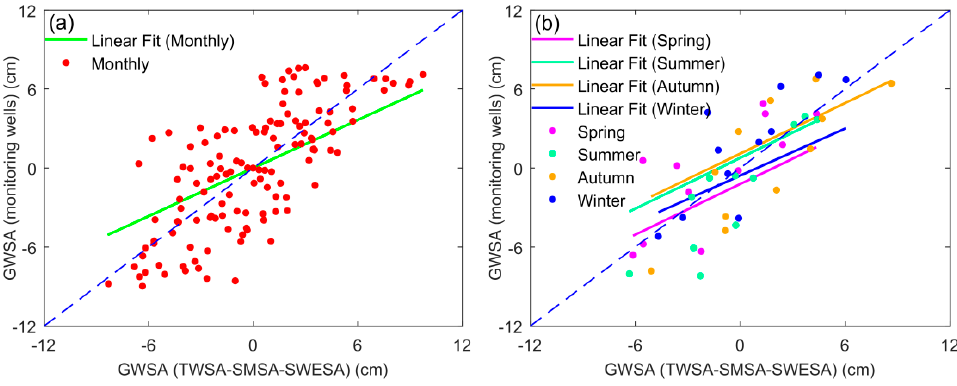
Figure 4. Comparisons of ( a ) monthly and ( b ) seasonal GWSA between GRACE and monitoring well observations in the 3H Plain.